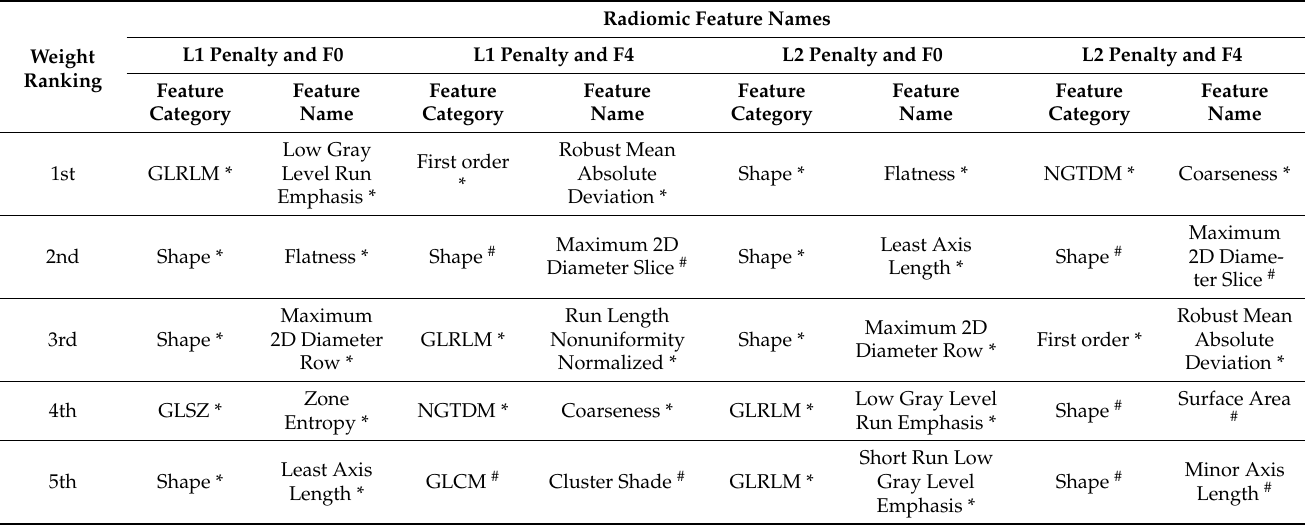
Table 3. Top five weighted radiomic features of trained logistic regression classifiers. The feature names are based on the Pyradiomics library used for research [16].